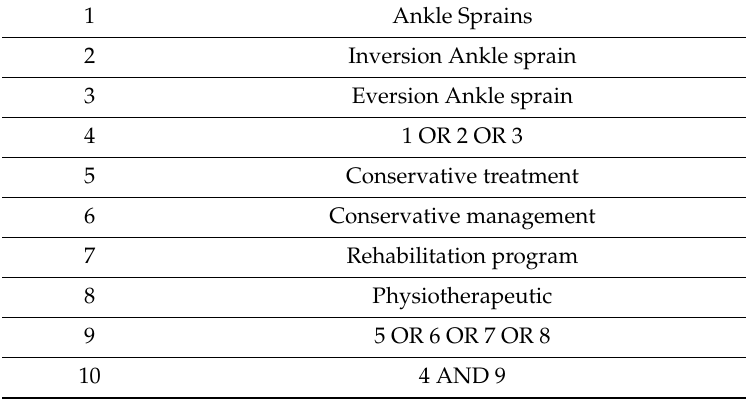
Table A5. PsycINFO. Total articles: 1371.